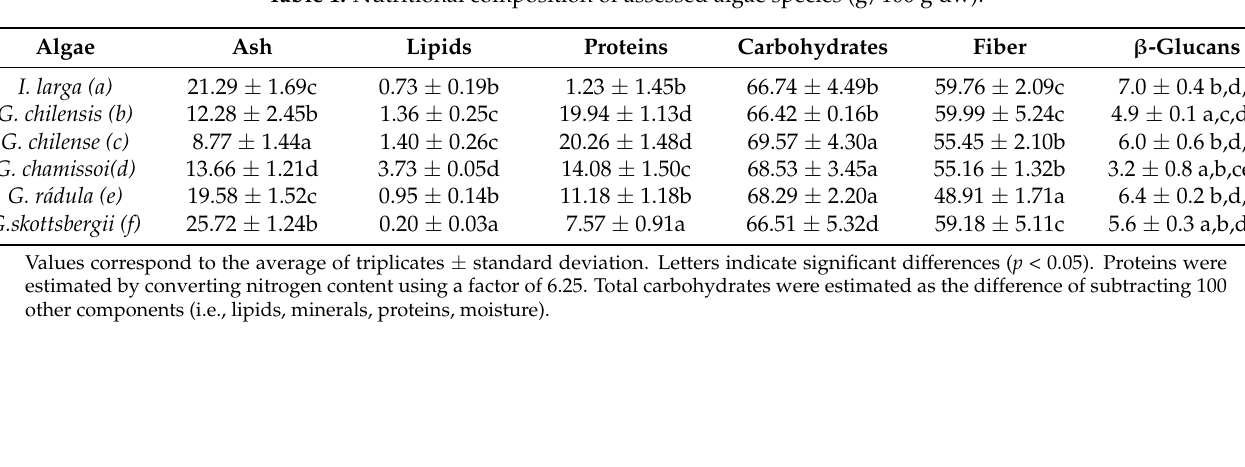
Table 1. Nutritional composition of assessed algae species (g/100 g dw). Algae